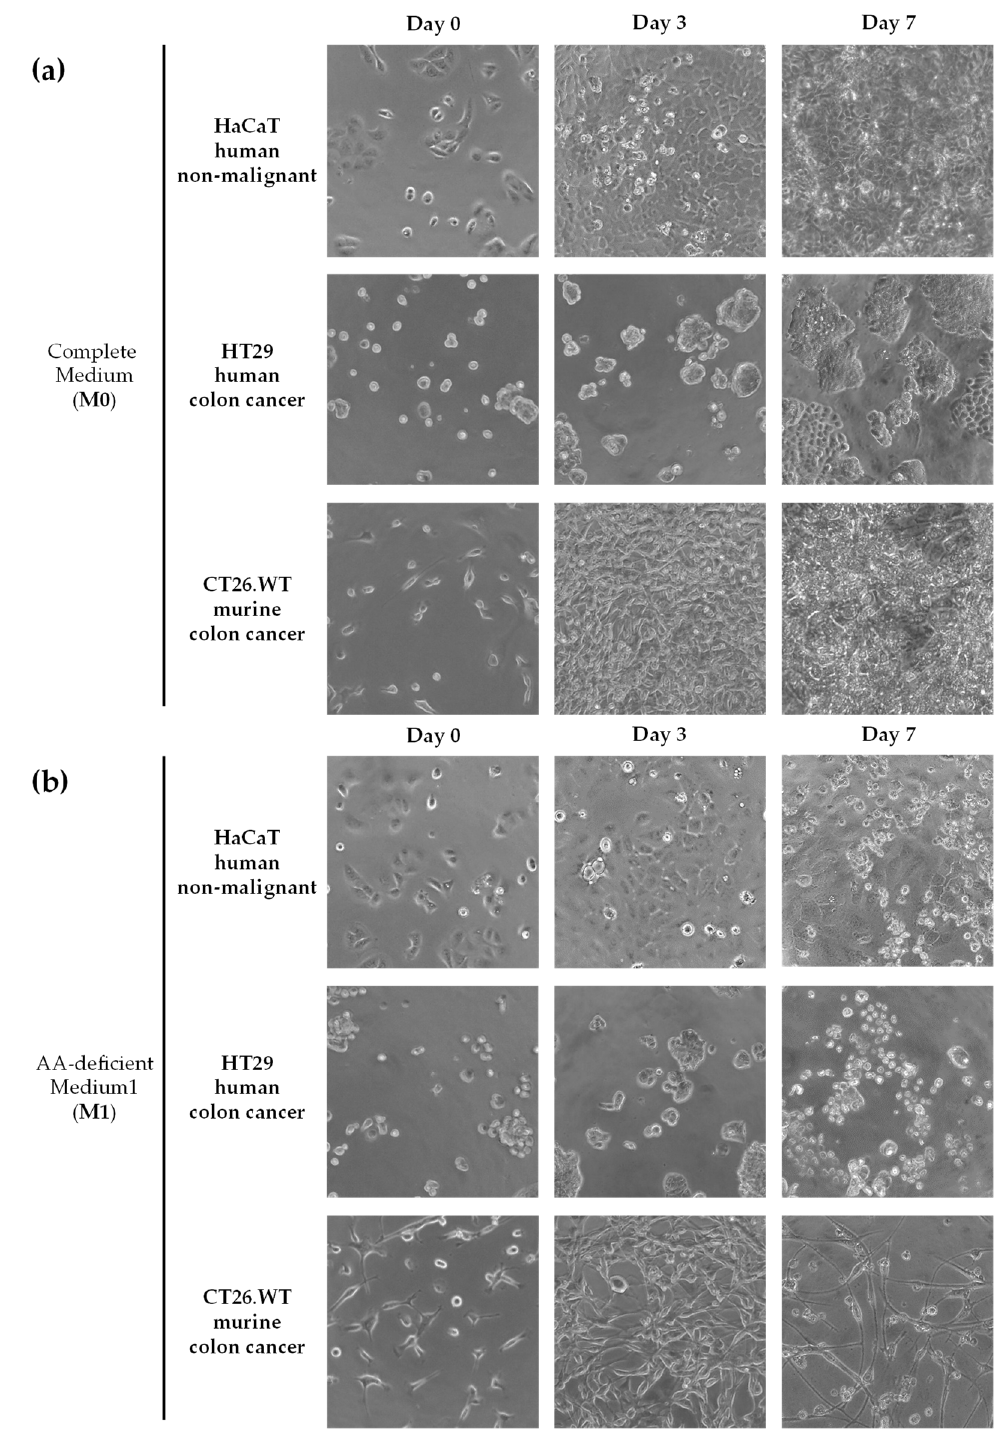
Figure 1. Anticancer activity of selective AA restriction. Representative photographs at 20× magni- fication are shown. The detailed composition of M0 ( a ) and M1 ( b ) are shown in Table 1.